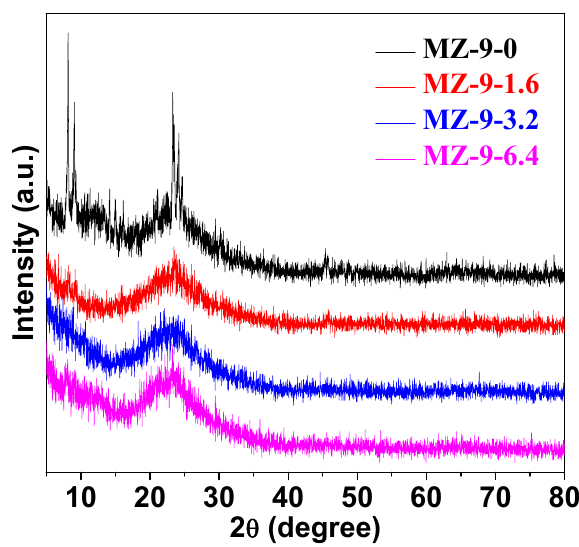
Figure 6. XRD patterns of MZ-9-0, MZ-9-1.6, MZ-9-3.2, and MZ-9-6.4.